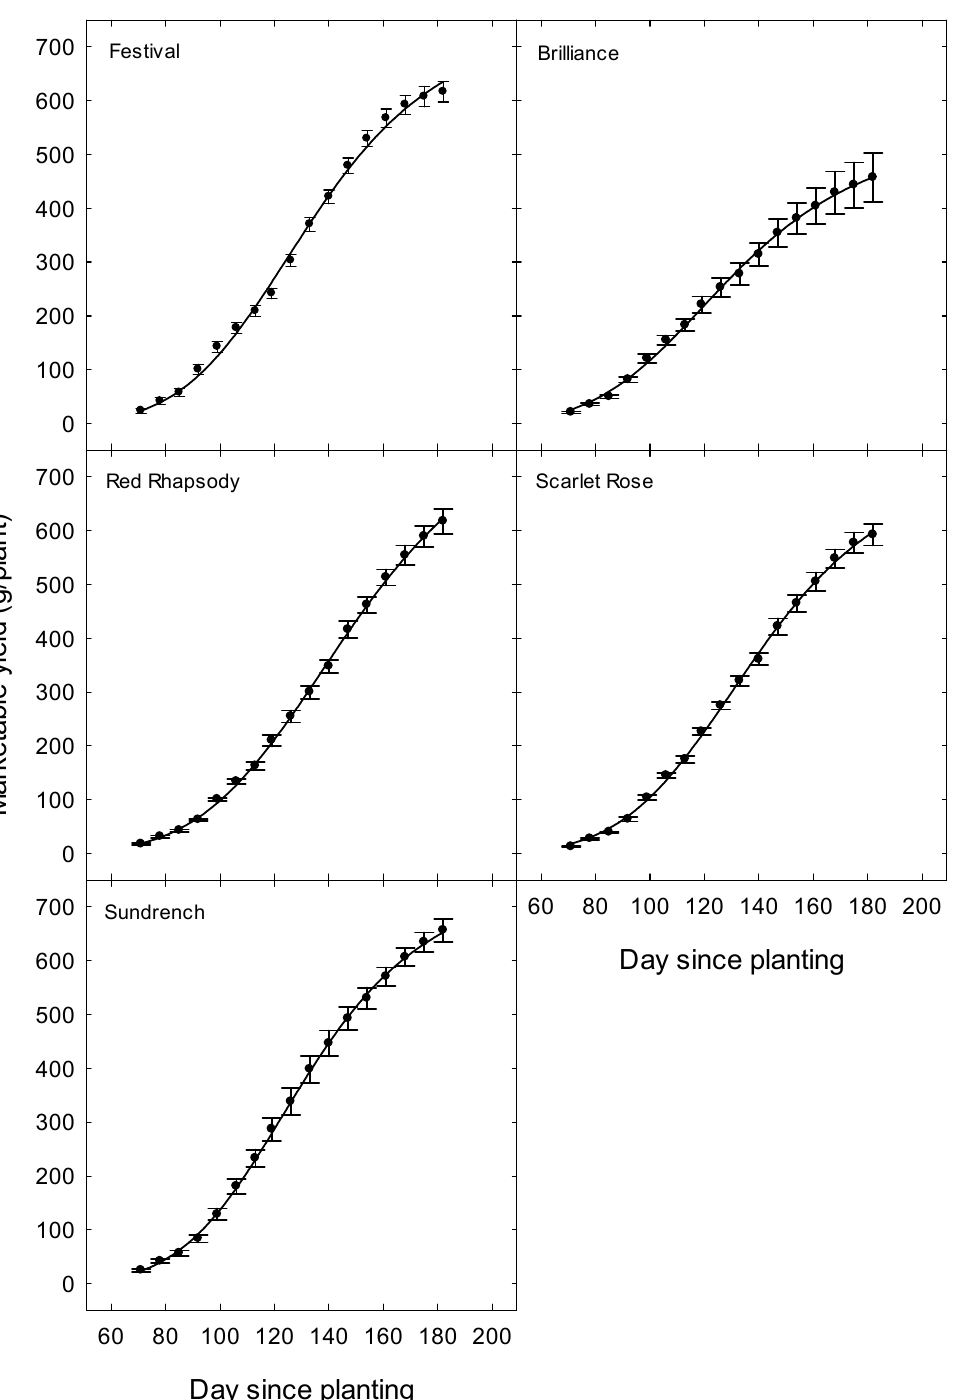
Figure 1. Seasonal changes in accumulated marketable yield in five strawberry cultivars in Queensland. Data are the means (±SE or standard error) of six replicates per cultivar. Day 1 was the date of planting on 29 April and Day 182 was the last harvest on 28 October ( n = 17). Details of the regressions are shown in Table 5.